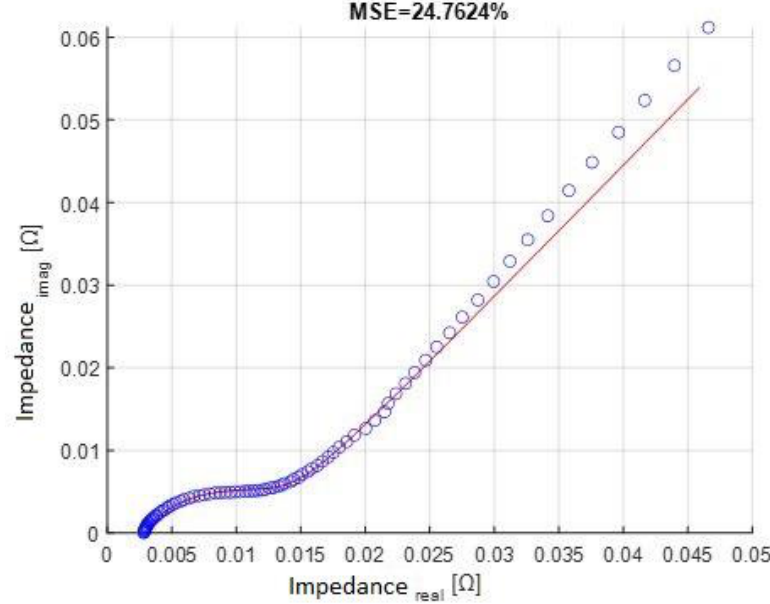
Figure 5. Example of the accepted electrochemical impedance spectra generated by augmented data.